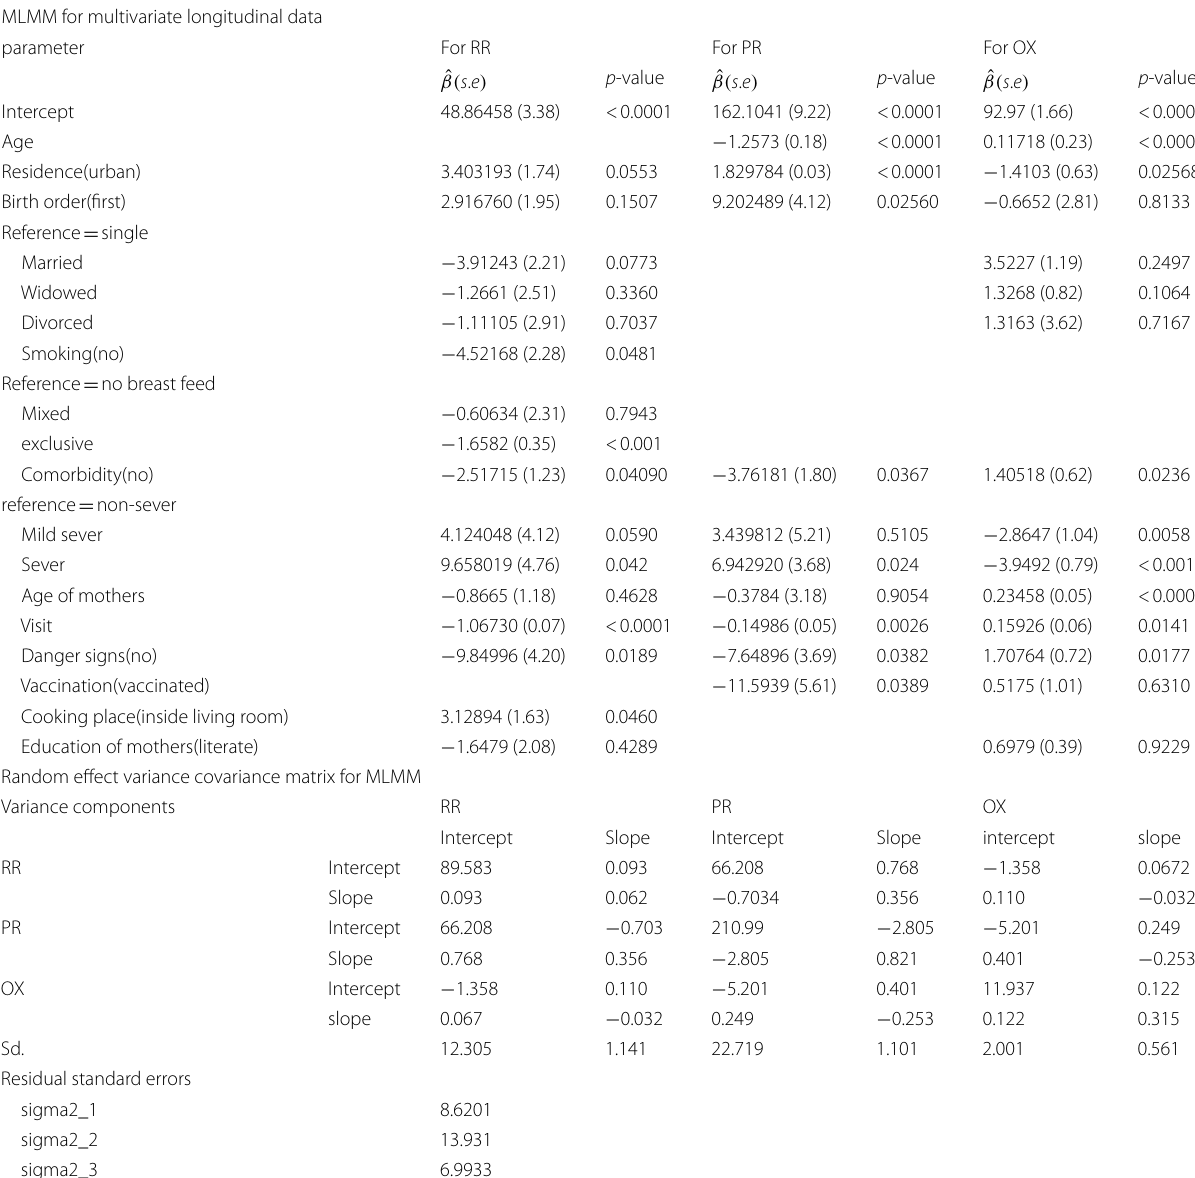
RR Respiratory rate, PR Pulse rate, OX Oxygen saturation, MLMM Multi variate linear mixed model